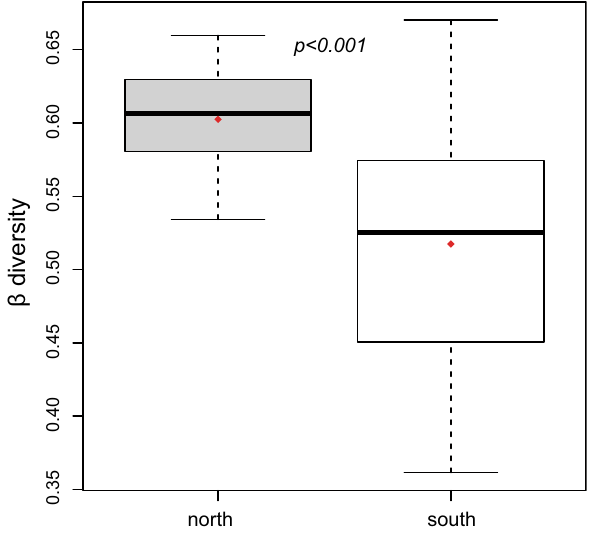
Figure 4. Comparison of floristic heterogeneity (β diversity) using distance-to-centroid (d cen ) between north- (gray) and south-facing (white) slopes by one-way